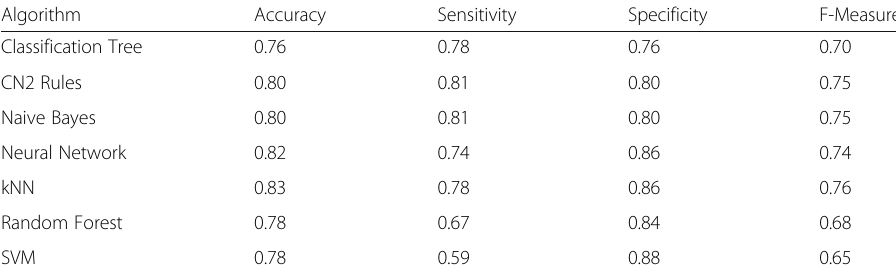
Table 7 Data Transformation: Equal Width, Feature Selection: Gain Ratio Algorithm